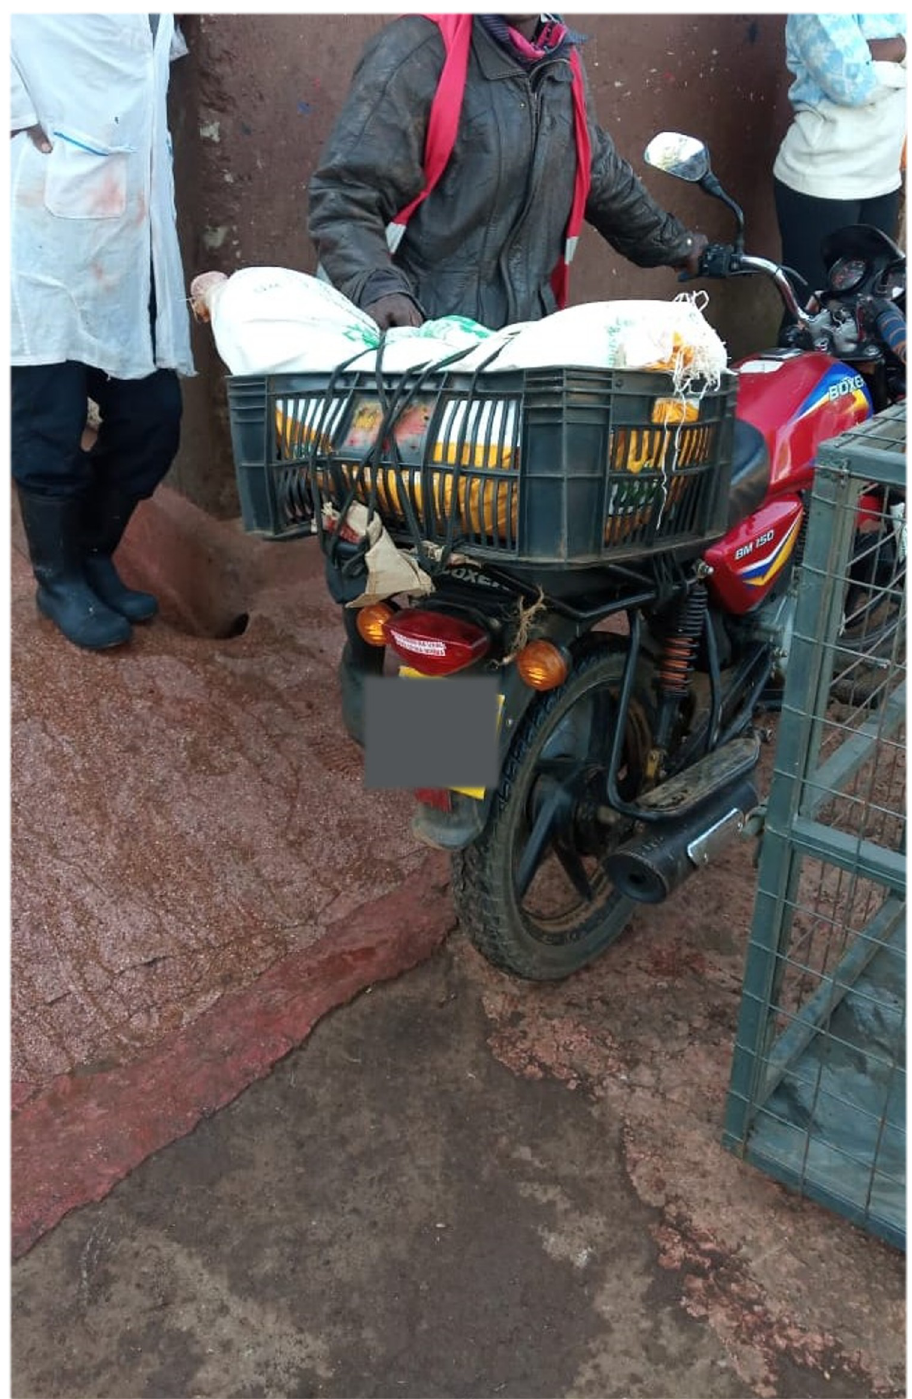
Fig 1. An image showing a pig being transported using a